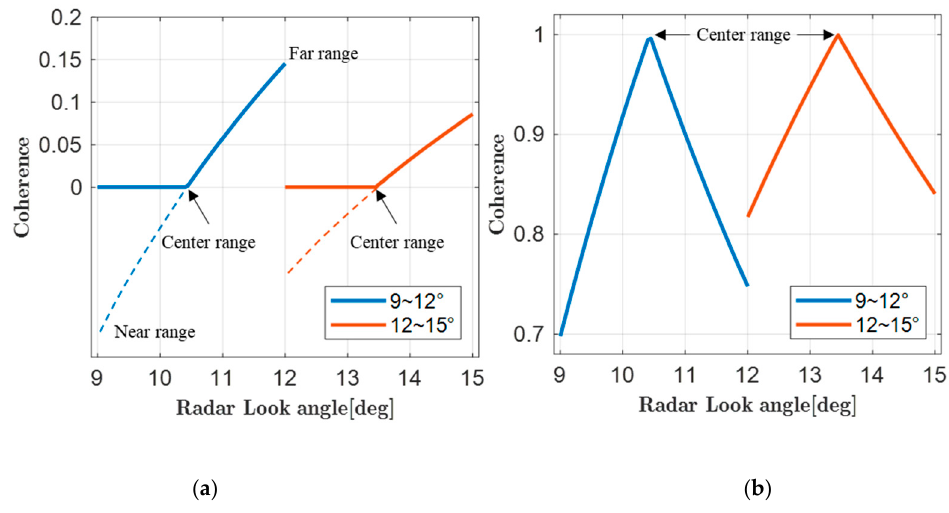
Figure 11. Coherence determined by baseline decorrelation, ( a ) before CFS compensation, and ( b ) after CFS compensation.